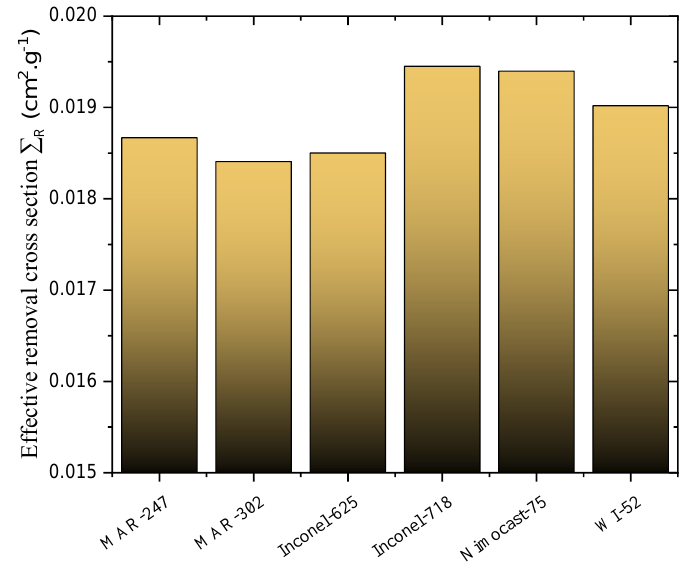
Figure 9. The fast neutron e ff ective removal cross-section of the studied alloys.